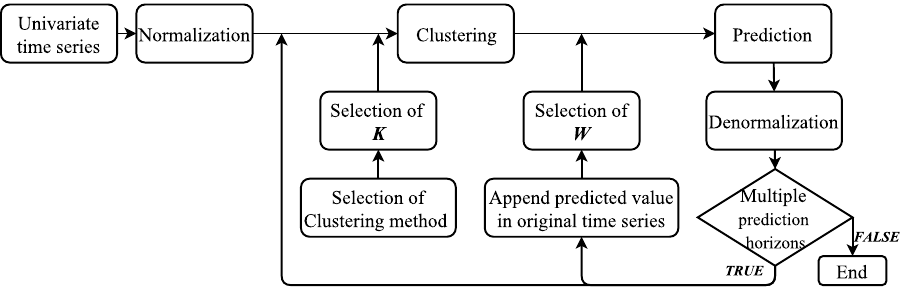
Figure 1. Block diagram of the PSF method (Source: